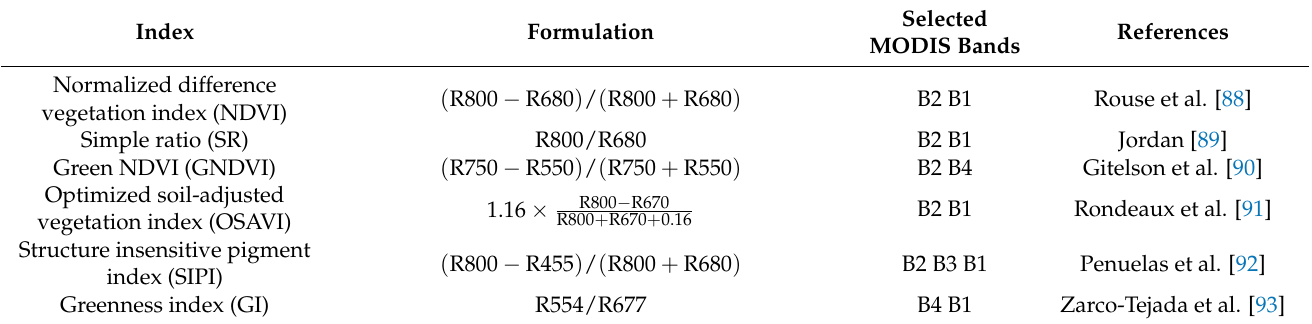
Table A1. Published vegetation indices evaluated in this